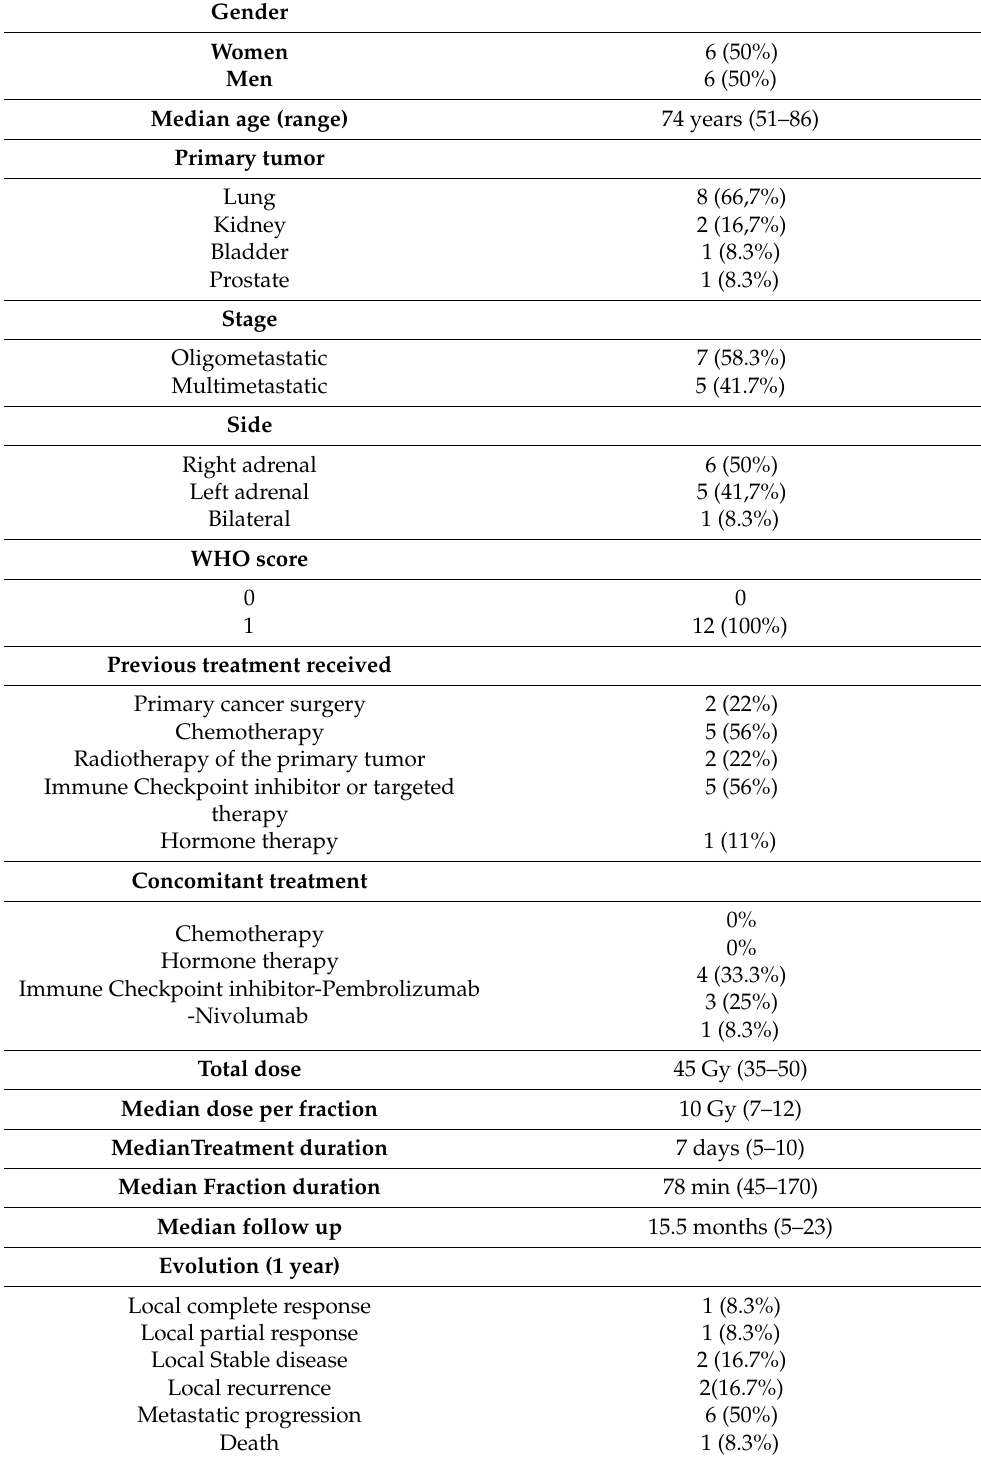
Table 2. Patient